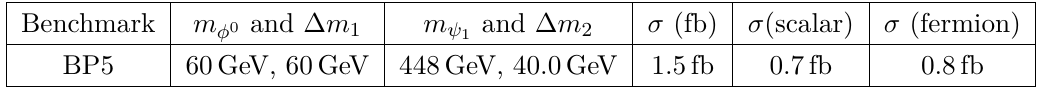
= 0 . 8 , P = − 0 . 3 polarization at e + e −